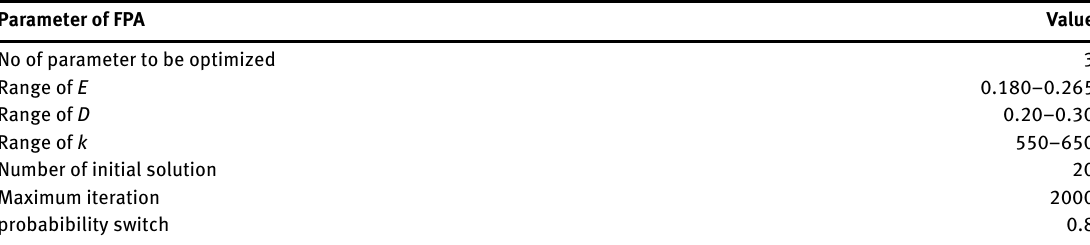
Table 3: Parameter Setting for FPA for NN Modeling of Flow